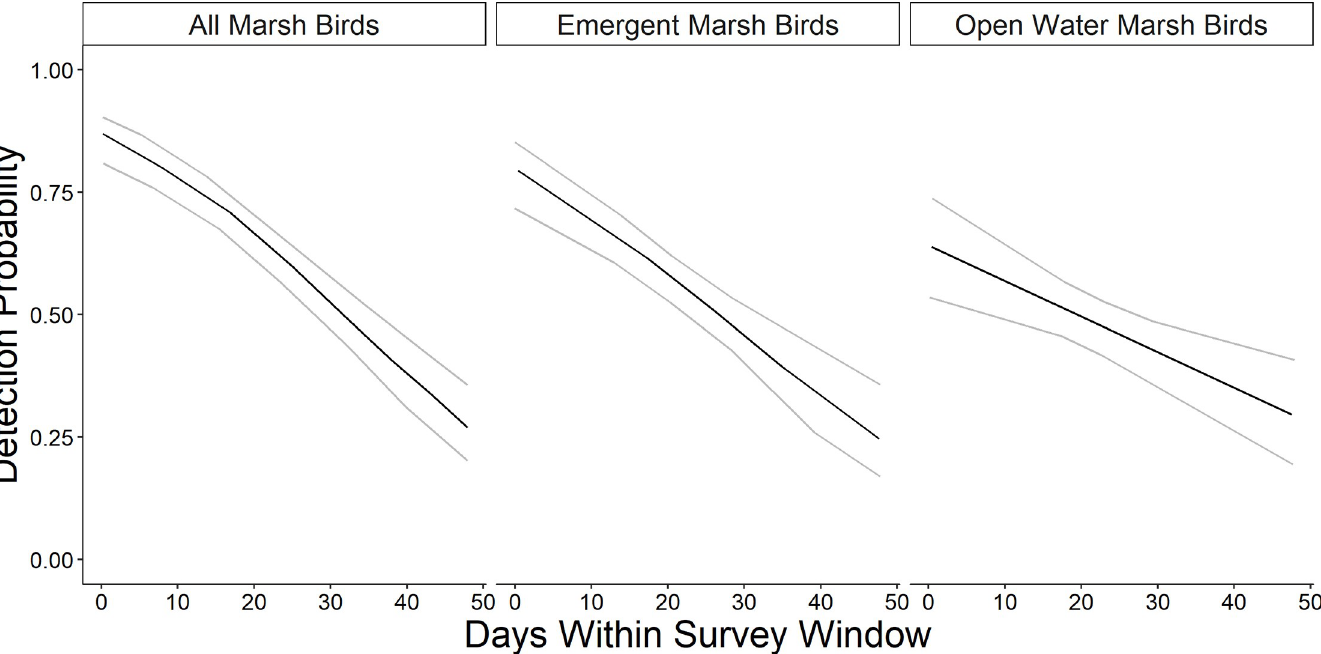
Fig 3. Model-estimated marsh bird detection probability (black line) for all three marsh bird groups ( ± 95% confidence limits [grey lines]) by adjusted date. Surveys were conducted from day 0 (April 15 or May 1, depending on latitude stratification) to day 48 across Illinois during late spring and early summer 2015–2017.